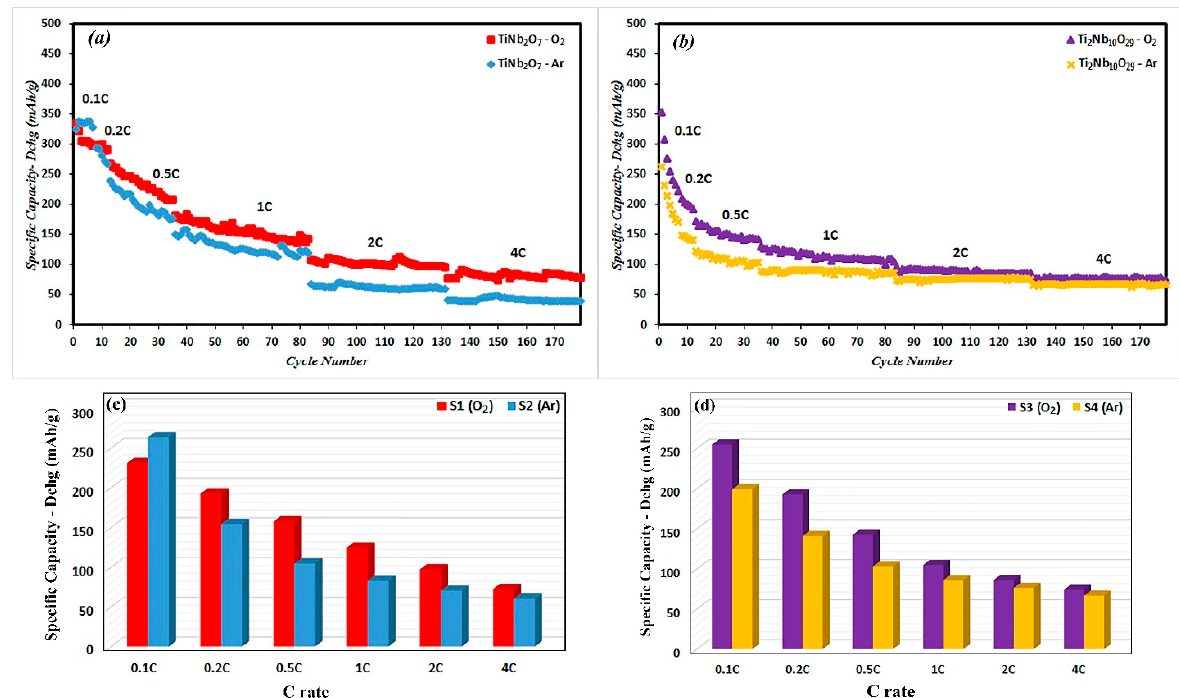
Figure 5. Cycling performance of the Electrodes synthesized in different atmospheres at various charge/discharge rates as indicated ( a ) TiNb 2 O 7 , ( b ) Ti 2 Nb 10 O 29 , ( c , d ) bar charts for comparing the discharge capacities at different C rates.